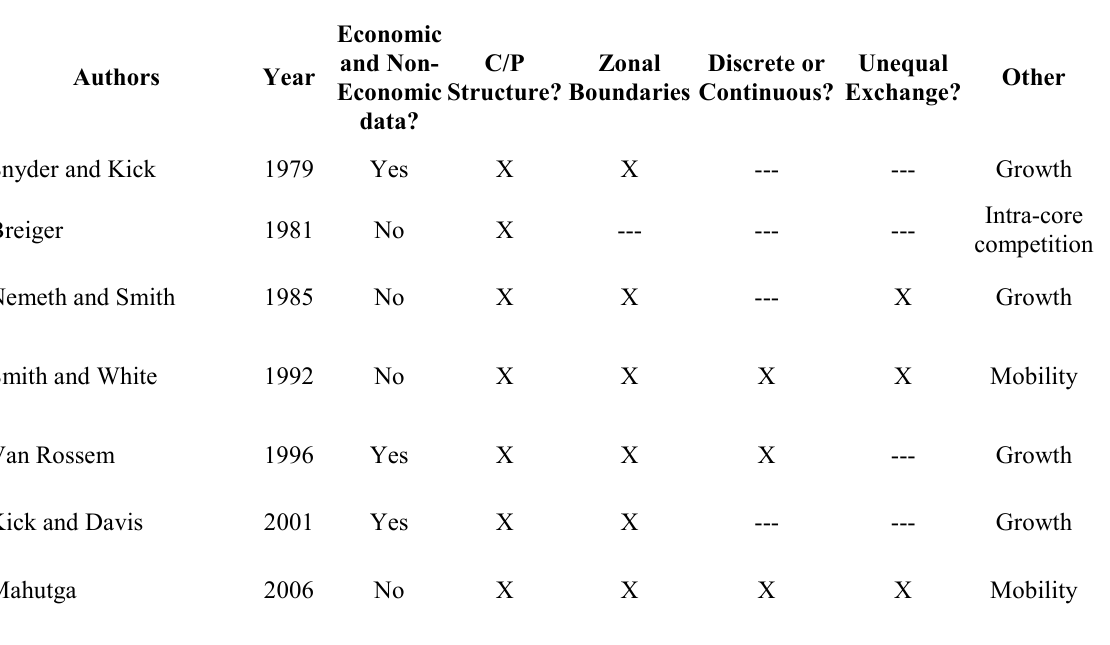
Table 2 delineates four main categories of inquiry with which researchers use